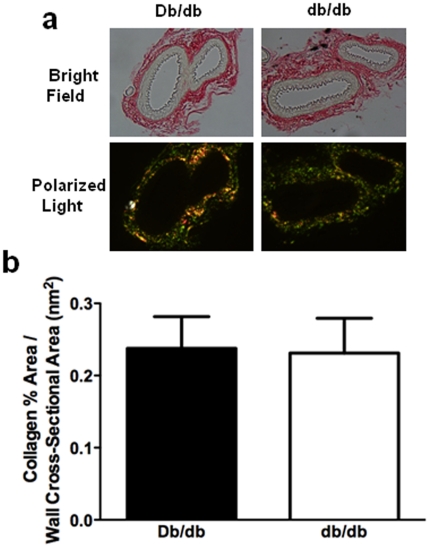
Vascular wall collagen content was unchanged in Db/db and db/db mice.
a. Representative MRAs from Db/db and db/db mice stained with picrosirius red under both bright field and polarized light. b. Quantification of vascular wall collagen and normalized to wall cross-sectional area. Unpaired t-test: Db/db vs db/db, NS, means ± SEM; n = 8 for each group. Scale bars = 40 µm.